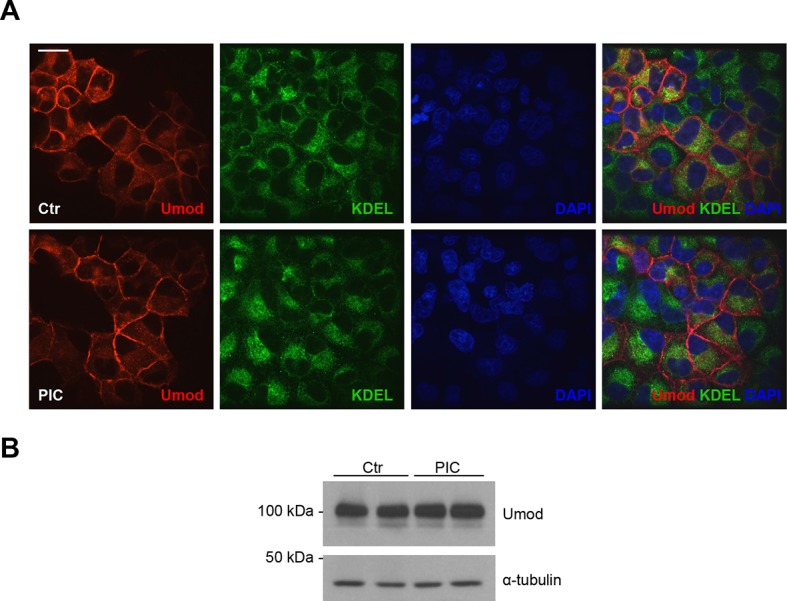
PIC treatment does not affect uromodulin intracellular distribution and expression.(A) Immunofluorescence analysis showing intracellular distribution of uromodulin in MDCK cells treated with vehicle (DMSO) (ctr) or protease inhibitor cocktail (PIC). KDEL is a marker of the endoplasmic reticulum (ER). Scale bar, 16 µm. (B) Representative Western blot analysis of uromodulin in lysates of MDCK cells under the same conditions as above. The upper band corresponds to the mature, fully glycosylated protein, the lower band corresponds to the immature protein carrying ER-type glycosylation (Schaeffer et al., 2012). Alpha-tubulin is shown as a loading control. PIC treatment does not alter uromodulin intracellular distribution nor its expression.